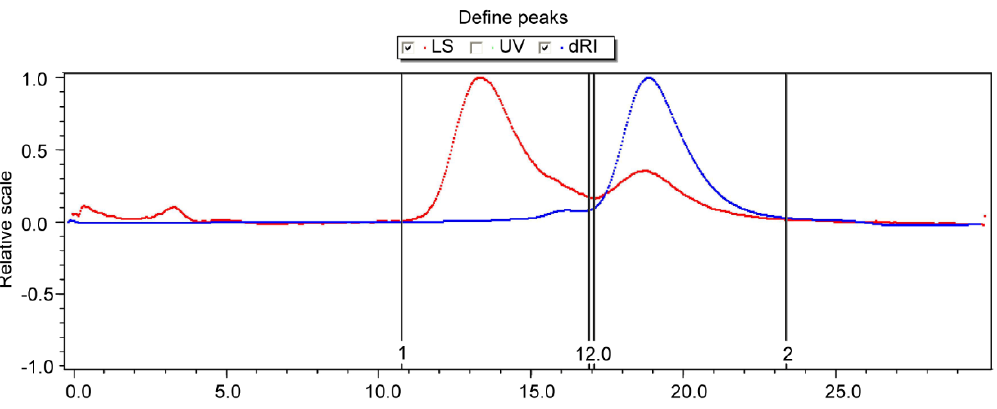
Figure 3. The GPC spectrum of RHWPs. Table 3. The molecular weight distribution of RHWPs (Mn: the number average molecular weight;